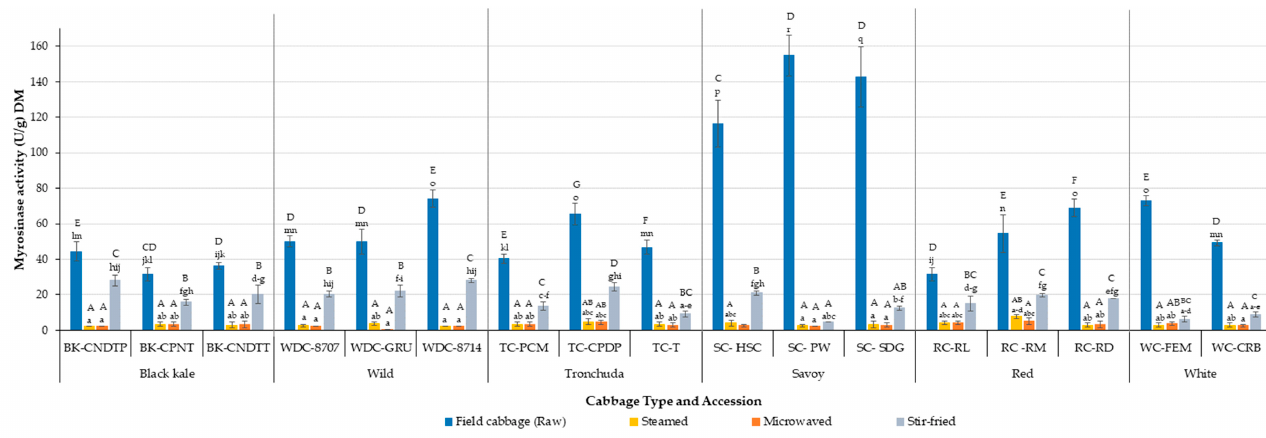
Figure 1. Comparison of the myrosinase activity of raw versus cooked cabbage morphotypes and accessions (U/g DW). Values are means of three biological (raw samples) or processing (cooked samples) replicates (each replicate comprising 4–5 cabbage heads) and two technical replicates ( n = 6). Error bars represent standard deviation from mean values. Letters “A–G”: bars not sharing a common uppercase letter differ significantly ( p < 0.0001) between accessions and treatments within a cabbage morphotype. Letters “a–r”: bars not sharing a common lowercase letter differ significantly ( p < 0.0001) between cabbage morphotypes, accessions, and treatments. Key: BK-CNDTP: cavolo nero di toscana o senza palla; BK-CPNT: cavolo palmizio; BK-CNDTT: cavolo nero di toscana o senza testa; WD-8707: wild cabbage 8707; WD-GRU: wild cabbage 7338; WD-8714: wild cabbage 8714; TC-PCM: penca mistura; TC-CPDP: penca povoa; TC-T: tronchuda; SC-HSC: hybrid savoy wirosa; SC-PW: pointed winter; SC-SDG: dark green; RC-RL: red langendijker; RC-RM: rocco marner (hybrid); RC-RD: red Danish; WC-FEM: early market; WC-CRB: couve repolho.